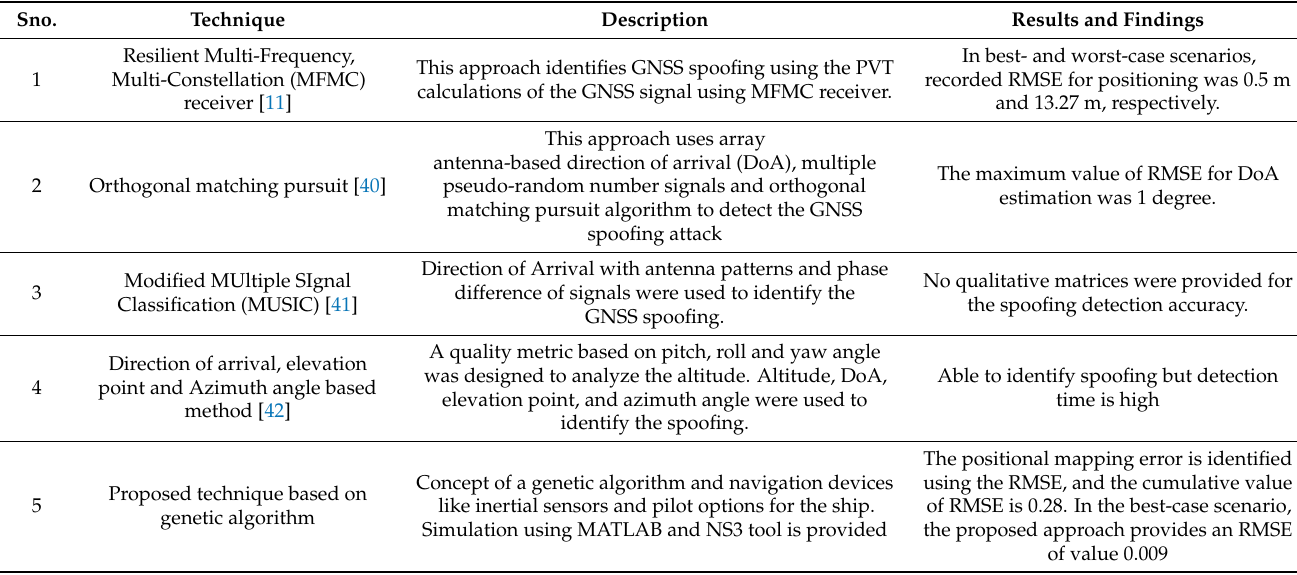
Table 5. Comparison of proposed approach with state of art techniques.